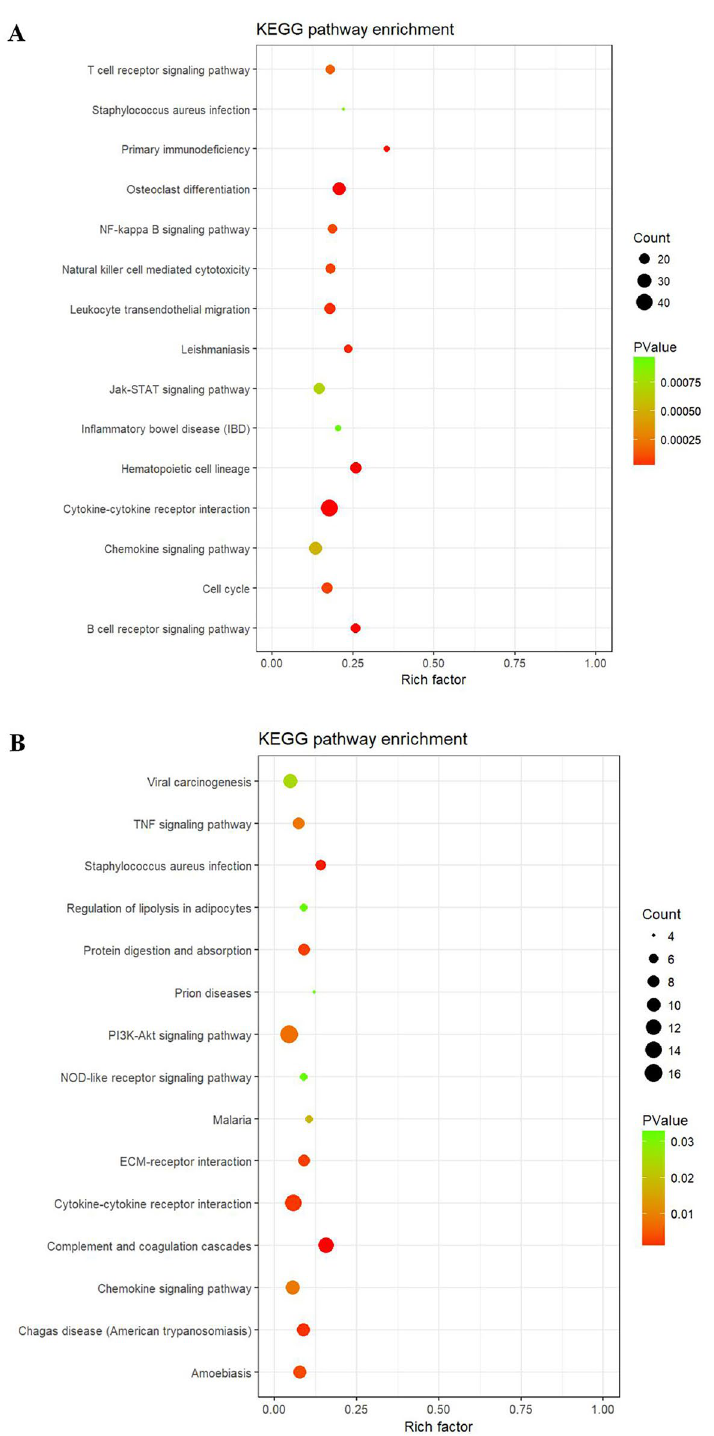
Figure 5. ( A ) KEGG pathway enrichment analysis showing genes involved in NF-κB signaling pathway and cytokine–cytokine receptor interaction were the largest in ARP mice compared with healthy mice. ( B ) KEGG pathway enrichment analysis showing genes involved in PI3K/AKT signaling pathway and cytokine–cytokine receptor interaction were the largest in DXM + GM enema treatment mice compared with ARP